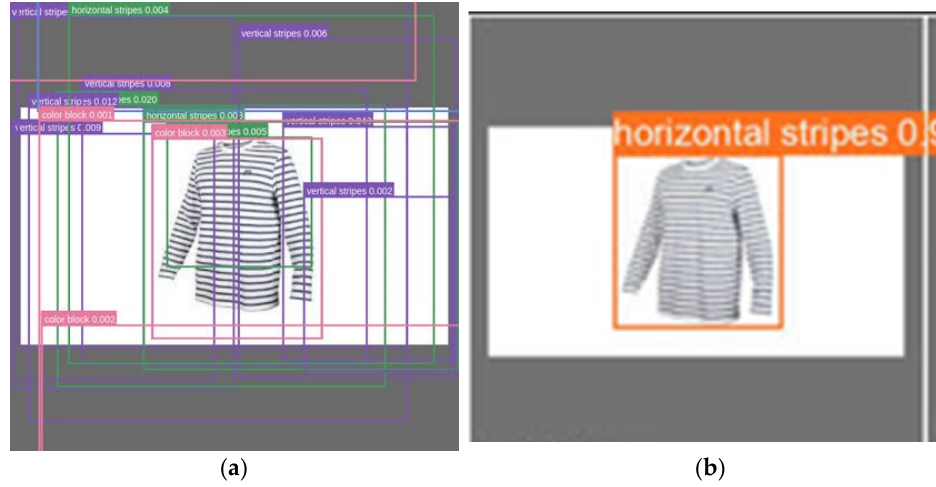
Figure 11. Anchor boxes: ( a ) candidates during the processing, ( b ) final choice.